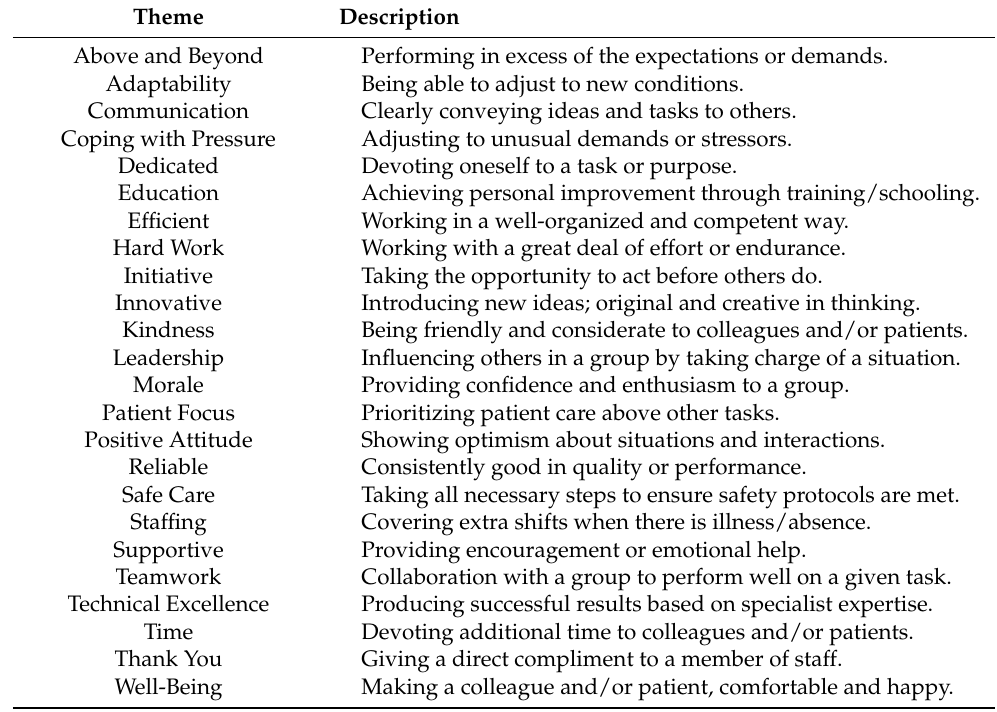
Table A1. Full list of “Learning from Excellence” dataset